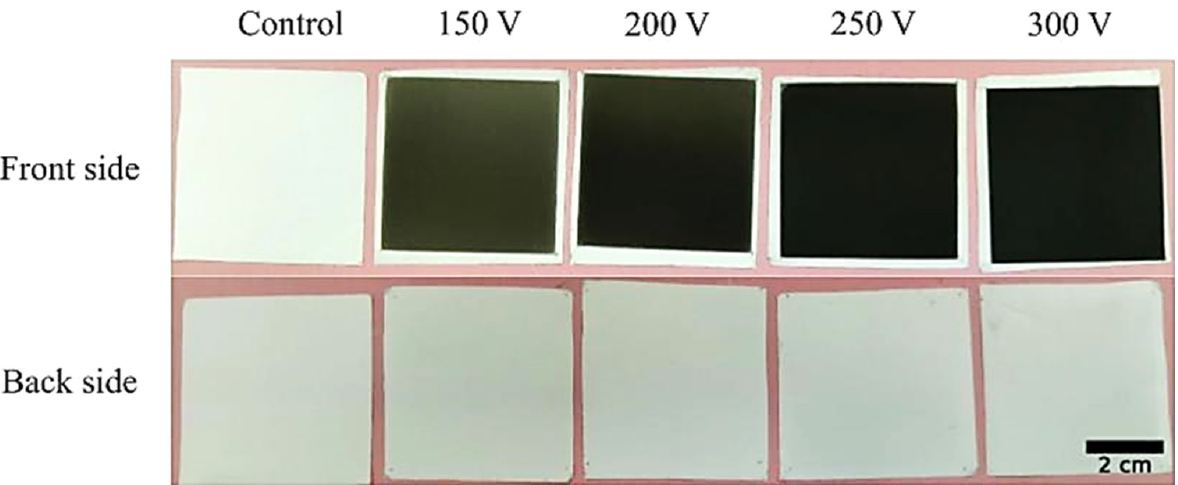
Figure 1. The photographs of the front and back sides of the membranes after the deposition of DLC coating under various capacitor storage voltages.